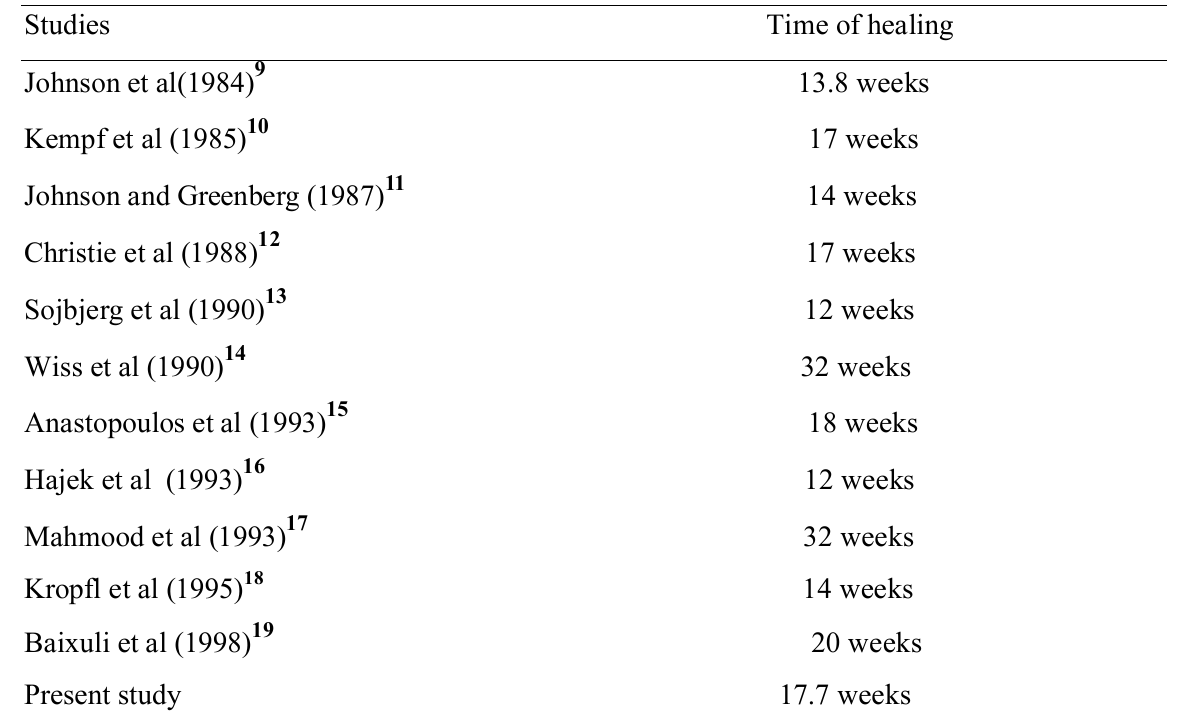
Table 8: Studies showing fracture healing (interlocking intramedullary nailing)